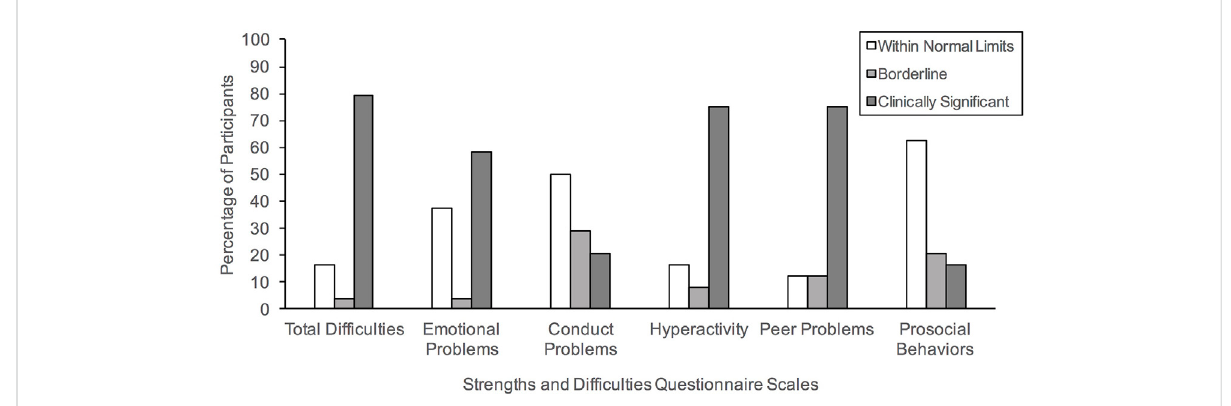
FIGURE 1 Percentage of our clinical sample meeting the three band categories (Within Normal Limits, Borderline, Clinically Signi fi cant) based on the parent-informant version of the Strengths and Dif fi culties Questionnaire.